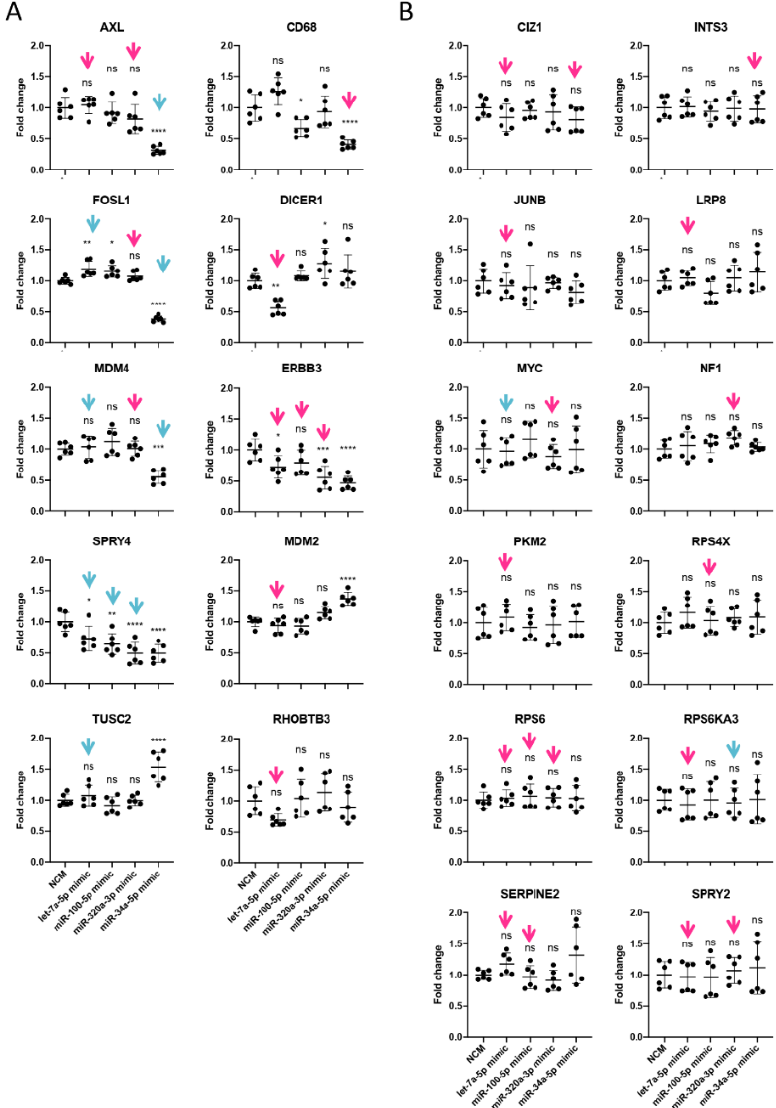
Figure 7. Expression of selected target mRNAs following transfection with 4 different miRNA mimics. The expression levels were normalized to the corresponding negative control mimic (NCM). Illustrated are 22 genes targeted at the 3 ′ UTR (blue arrows) or CDS (red arrows) whose expression changes ( A ) or remains unaltered ( B ) upon 50 nM mimic treatment for 72 h. Statistical significance was determined by one-way ANOVA, followed by Dunnett’s multiple comparisons test with ns, not significant; * p ≤ 0.05; ** p ≤ 0.01; *** p ≤ 0.001; **** p ≤ 0.0001. To validate potential functional effects, four miRNAs were selected based on their frequent occurrence in miRNA-mRNA hybrids (i.e., let-7a, and miR-320a), high expression in melanoma cells (i.e., let-7a, and miR-100), as well as their involvement in melanoma drug resistance (i.e., miR-34a, and miR-100 [39]). Transfection of mimics resulted in high intracel- lular levels of the respective miRNAs albeit to various degrees (Figure S4A). Among their respective interaction partners found in miRNA-mRNA hybrids, 22 mRNAs were selected for validation, in order to identify potential functional differences between canonical (i.e., 3 (cid:48) UTR) and non-predicted and non-canonical (i.e., binding patterns) (Figure 6). A